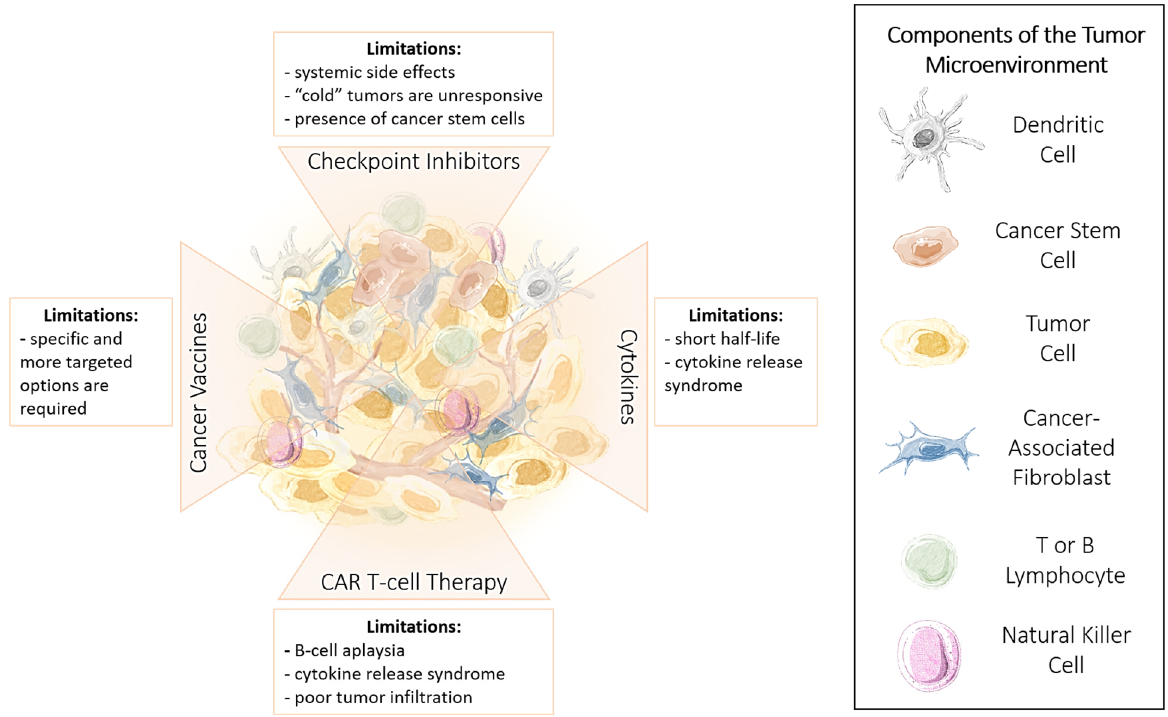
Figure 1. Limitations of Immunotherapy. There are four main categories of immunotherapy: immune checkpoint inhibitors (i.e., PD-1/PD-L1 and CTLA-4), cytokines (i.e., IFN- α ), cancer vaccines, and chimeric antigen receptor T cells (CAR T cell therapy). Although these therapeutic options have been successful in the clinic, only a small subset of patients respond. Several limitations of this approach are summarized in the schematic. Abbreviations: CTLA-4, cytotoxic T-lymphocyte- associated protein 4; IFN- α , interferon-alpha; PD, programmed cell death protein-1.